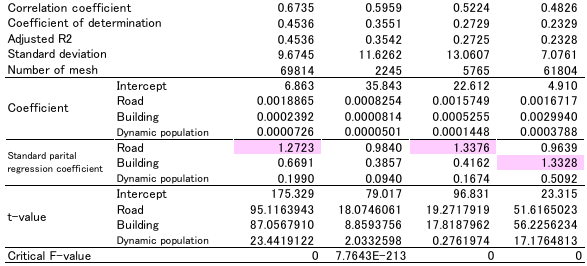
Table 7. Results of multiple regression analysis